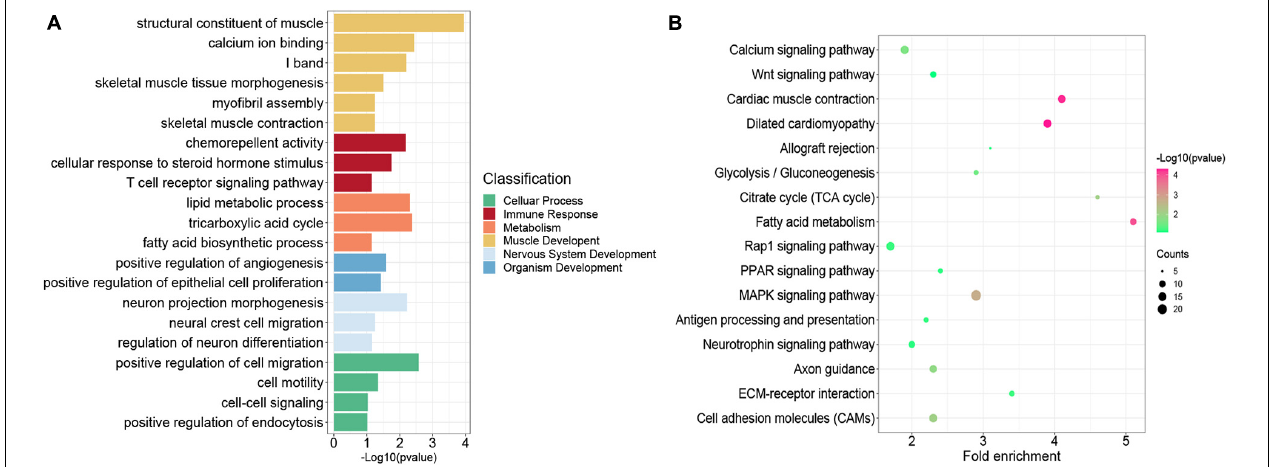
FIGURE 5 | Functional enrichment analysis of genes modified by H3K27me3. (A) The GO enrichment analysis of the HDEGs. The colors represent the different classifications of GO terms. (B) The KEGG pathways analysis of